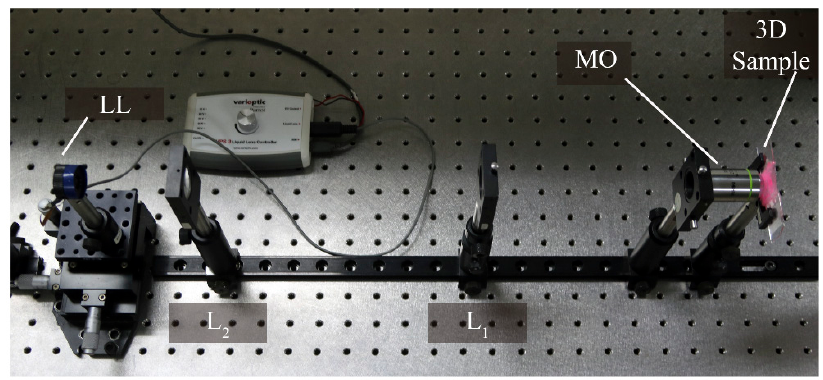
Figure 4. Details of the experimental setup. Figure 4 . Details of the experimental setup. Table 1. Optical power in the LL and effective displacement of the ORP induced while changing the voltage.